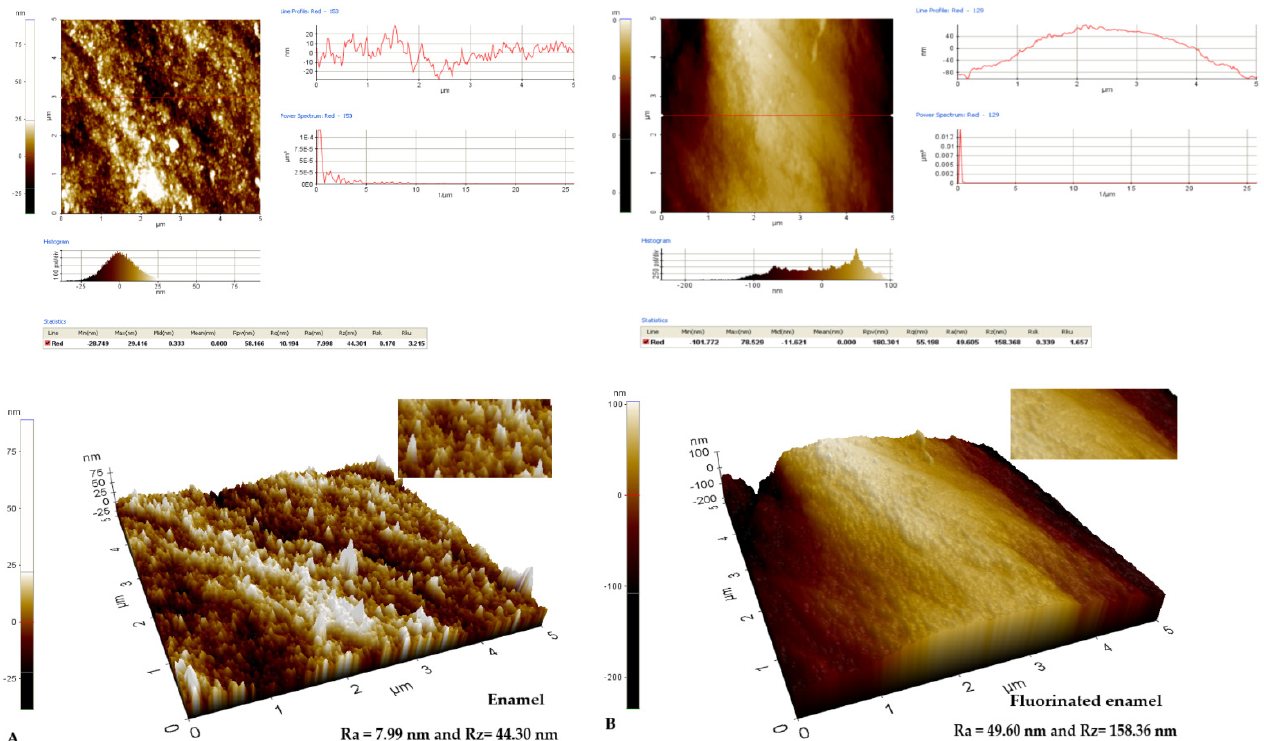
Figure 5. AFM images from the enamel surface layer on the X Scan layer 5 µ m/Y Scan layer 5 µ m: ( A ) Two-dimensional and three-dimensional AFM image of the enamel structure in the enamel without fluoridation Ra = 7.99 nm and Rz = 44.30 nm; ( B ) Two-dimensional and three-dimensional AFM image of the enamel structure in the enamel after fluoridation with varnish Ra = 49.608 nm and Rz = 158.368 nm.